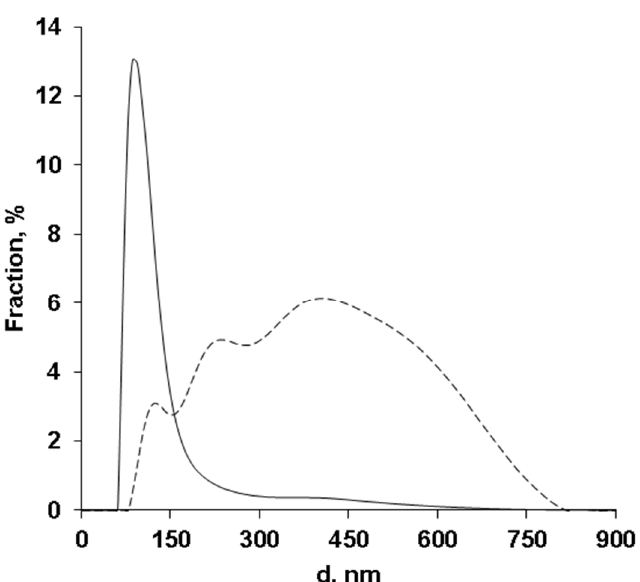
Figure 2. Surface tension isotherm at the water/air interface of the NVPAGE amphiphilic copolymer at a temperature of 298 K.